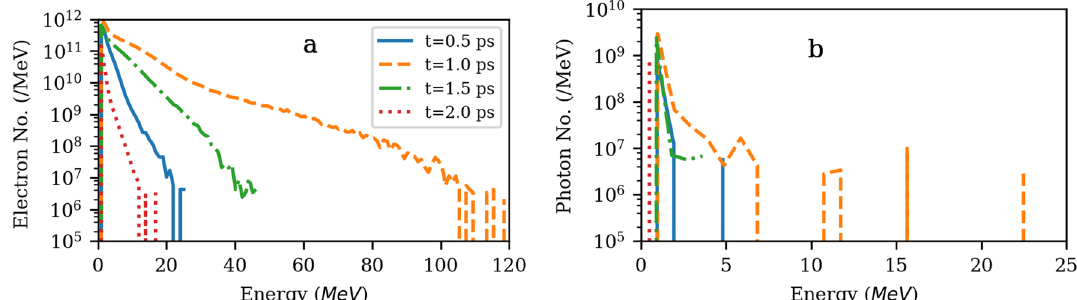
Figure 4. Temporal evolution of electron energy ( a ) and bremsstrahlung emission ( b ) due to the interaction of 20 a 4.1 × 10 W/cm 2 laser pulse with a 25 nm gold foil for the FI